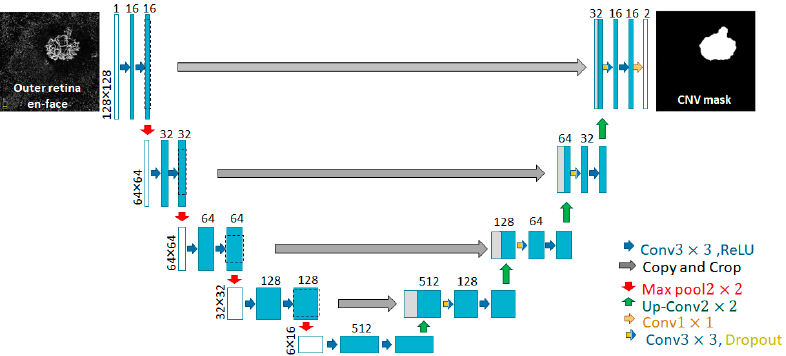
Figure 3. Structure of SEG-CNV (customised U-net network). The red, orange, green and blue arrows represent transfer function, convolution function with 1 × 1 convolution kernel and sigmoid function, up-sampling function, convolution function with 3 × 3 convolution kernel and RELU function, respectively. Blue/yellow arrows indicate convolution with